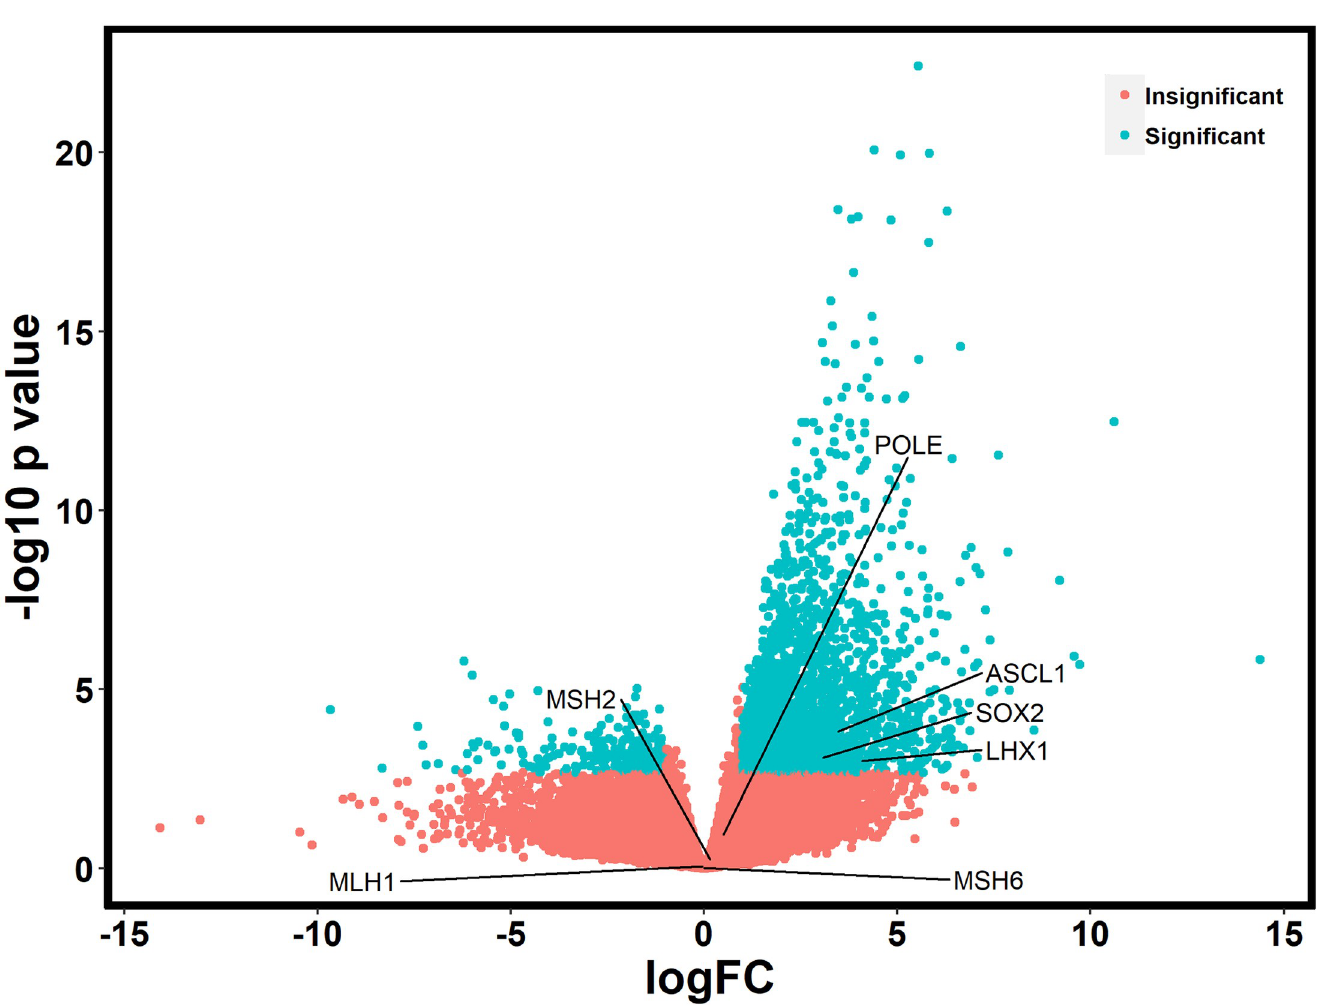
Fig 3. Differential gene expression between DACH1 mutated patients and wild-type. A marked increase in significantly upregulated genes is noted.